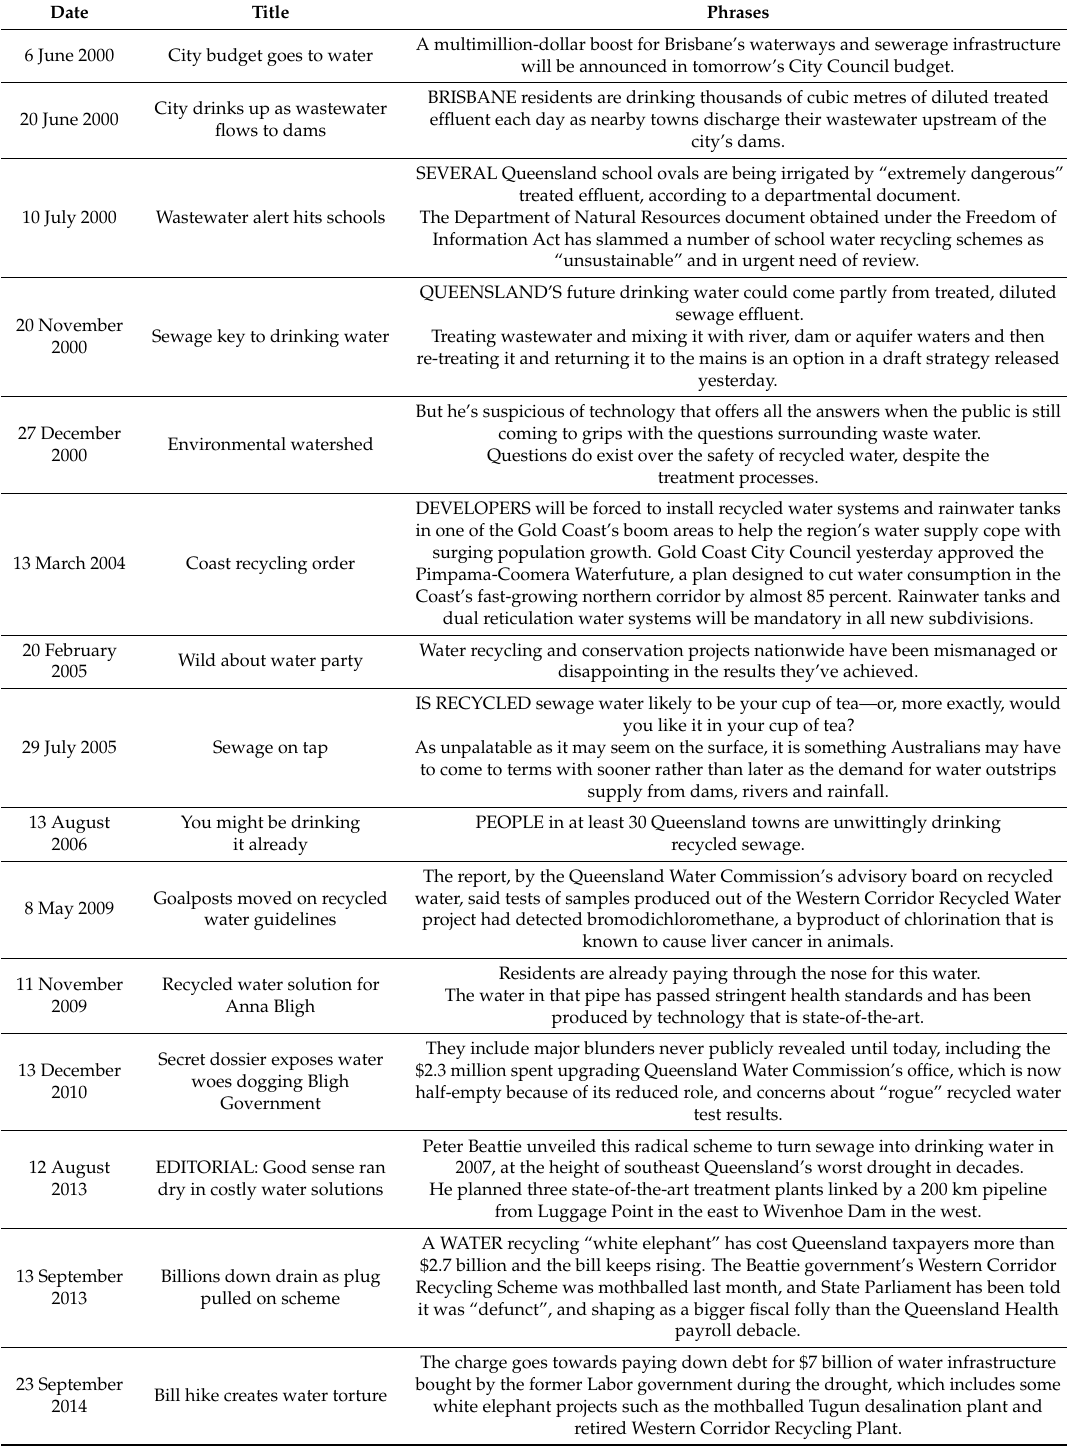
Table 4. Excerpts of selected newspaper articles in The